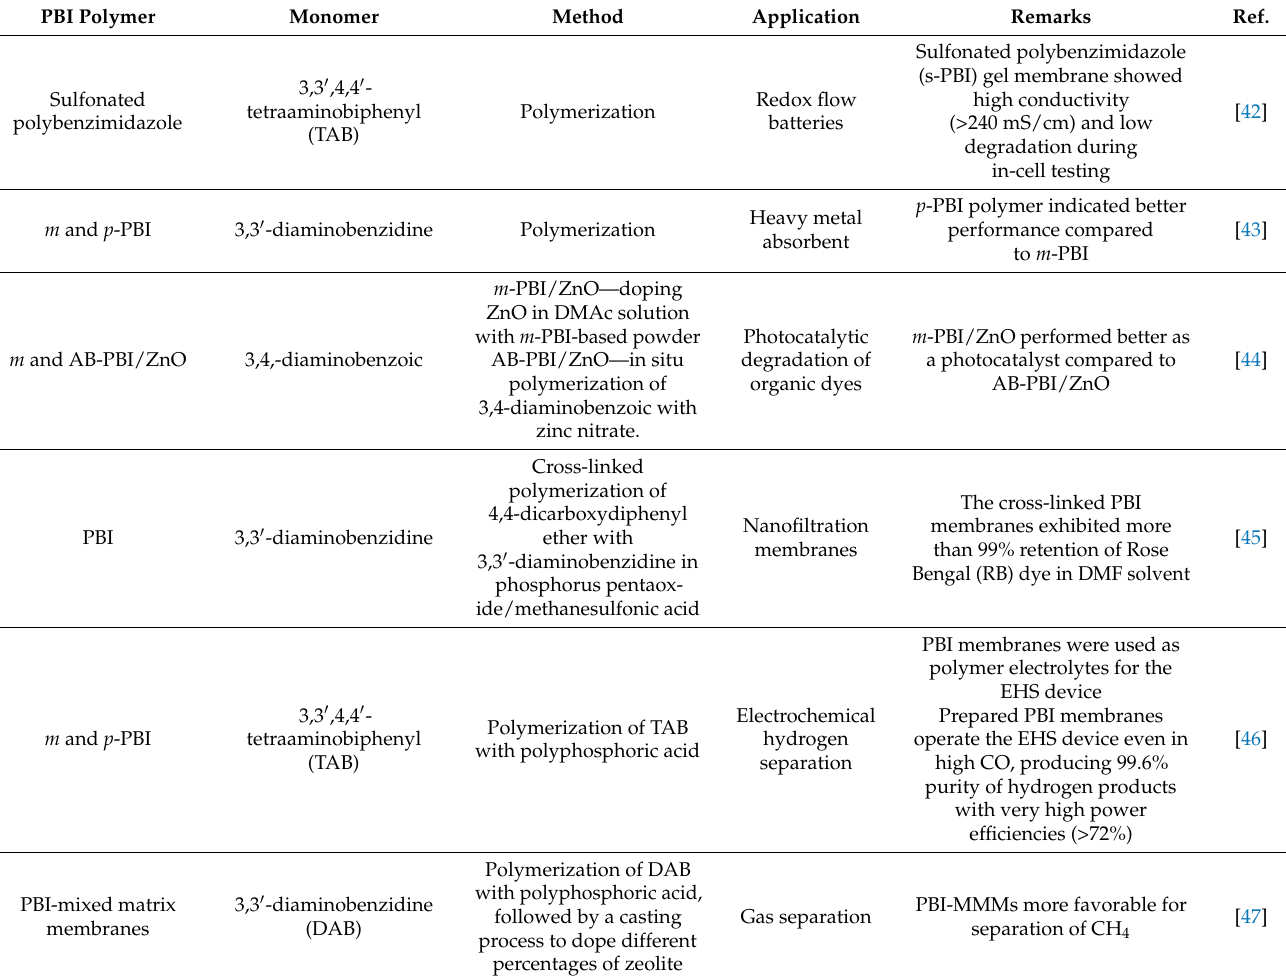
Figure 4. Possible proton transfer pathway for the sulfuric acid-PBI polymer [40]. Table 1. Preparation methods for PBI polymers and their